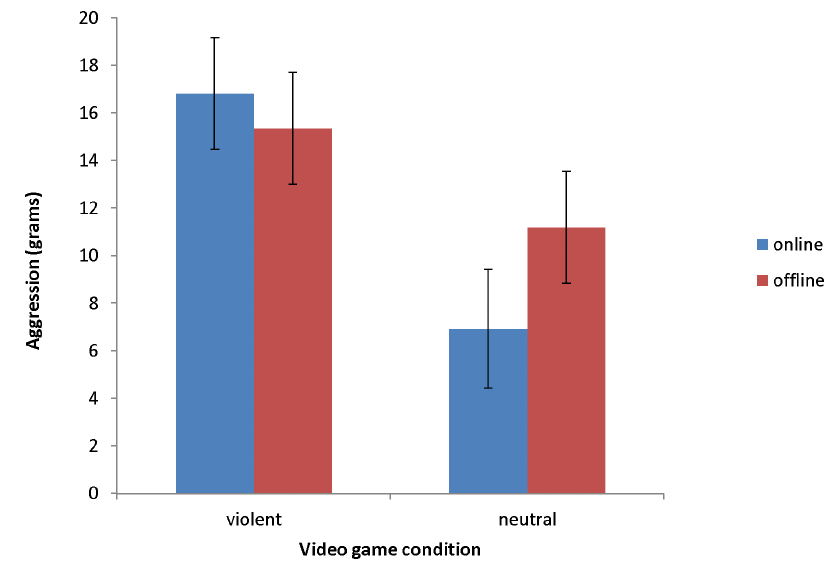
Figure 1. Mean grams of chilli sauce by experimental condition.